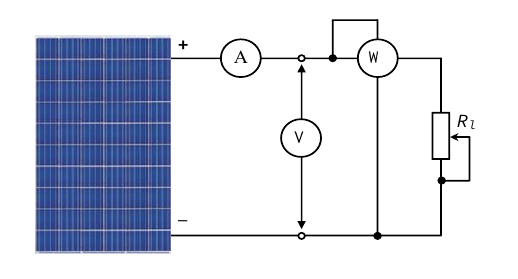
Fig. 3. The circuit of the experiment.